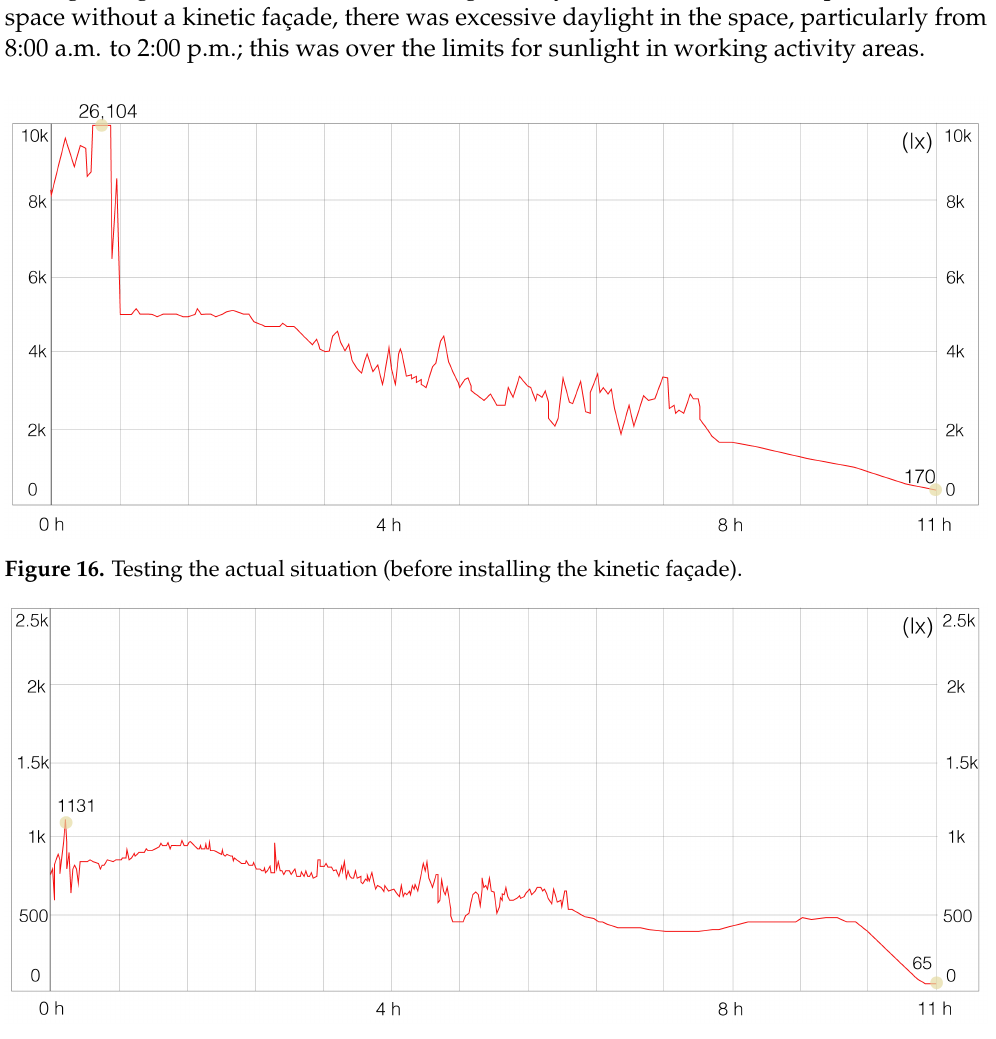
Figure 17. Testing the actual situation (after installing the kinetic